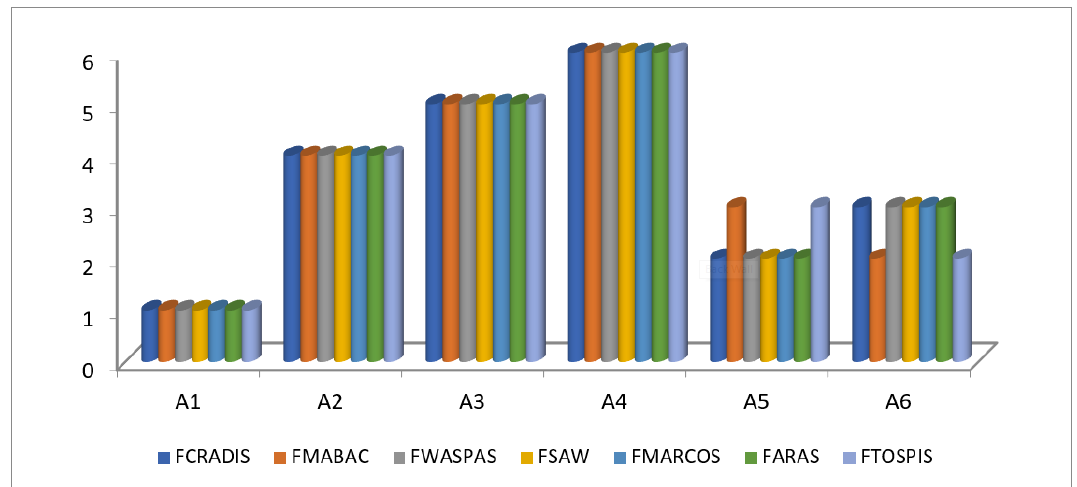
Figure 1. Validation of the results.